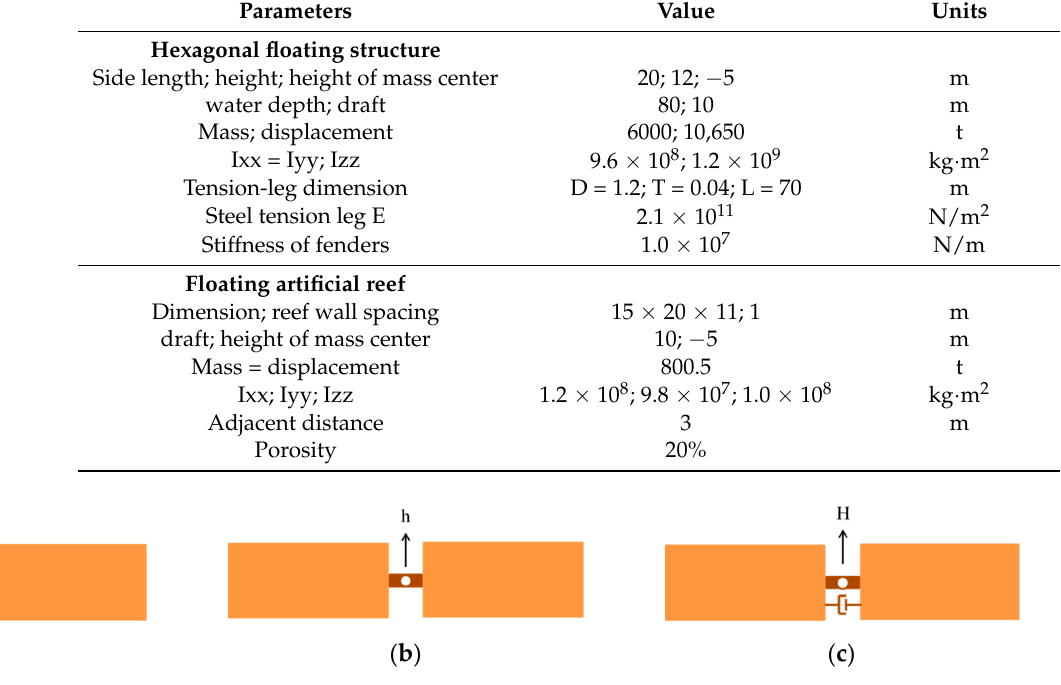
Table 1. Main design parameters of the MFS system.